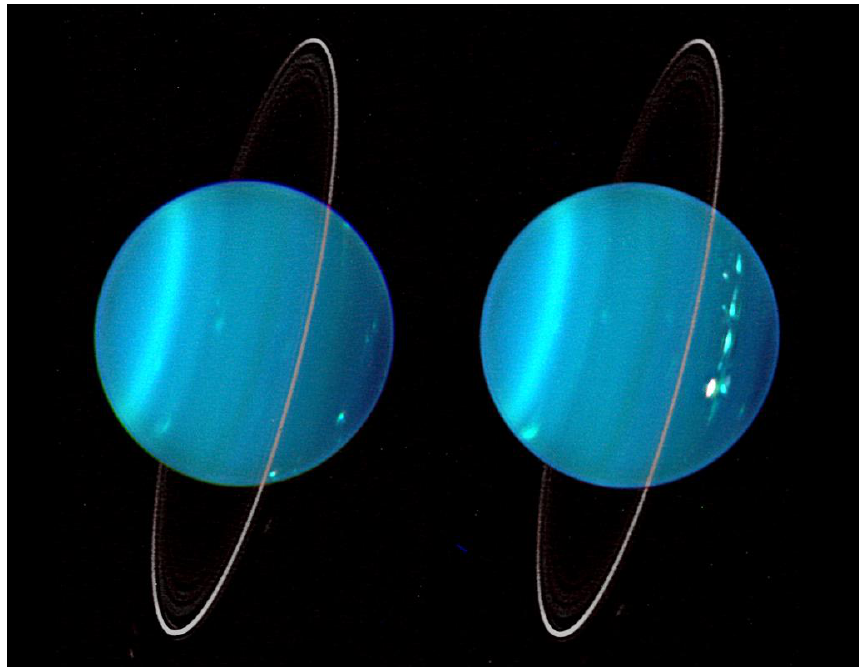
Figure 1. Infrared composite image of Uranus in 2004. The Berg is the cloud feature in the right-hand image on the planetary horizon between 07:00 and 08:00. Image courtesy of NASA/JPL-Caltech. Additional image credit Lawrence Sromovsky, University of Wisconsin-Madison/ W.W. Keck